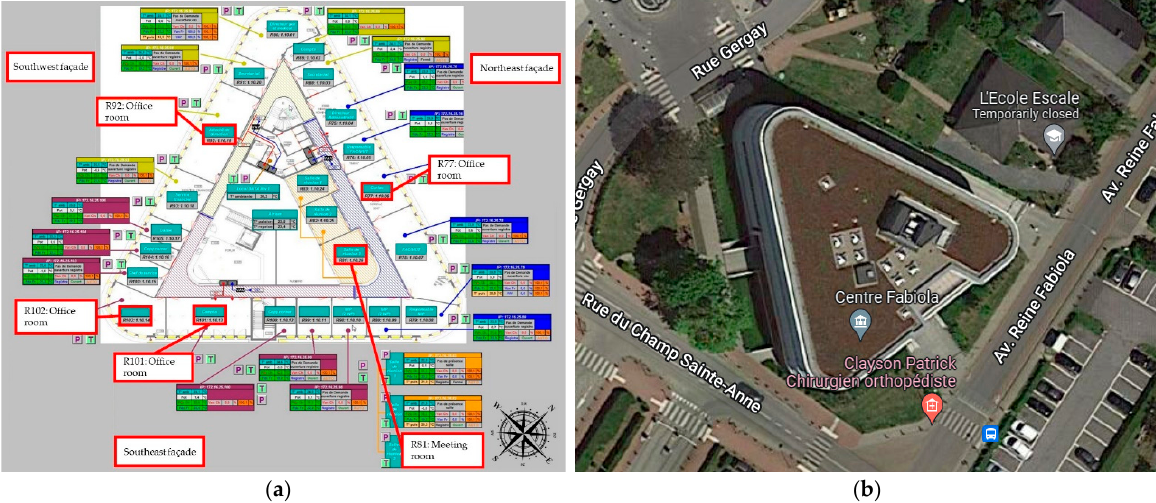
Figure 4. Reference building measurement locations used for the thermal comfort evaluation: ( a ) measurement locations on Floor + 1; ( b ) satellite image with landscape from Google